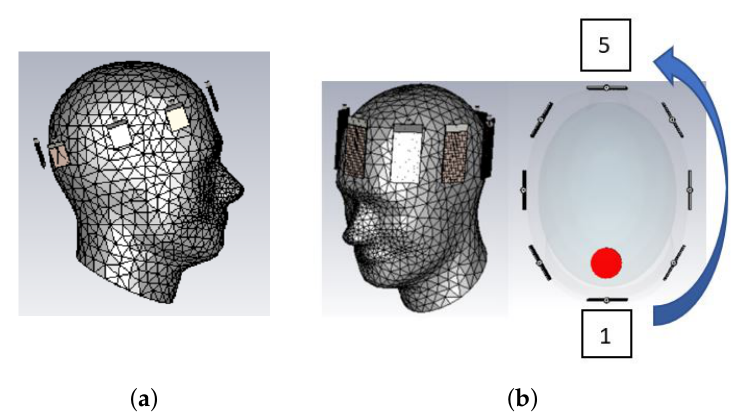
Figure 6. ( a ) 8-PSMA array (“System 1”) ( b ) 8-MTS-Enhanced PSMA array (“System 3”) and its transversal view. “System 2” is equal to “System 2” except for including non-enhanced